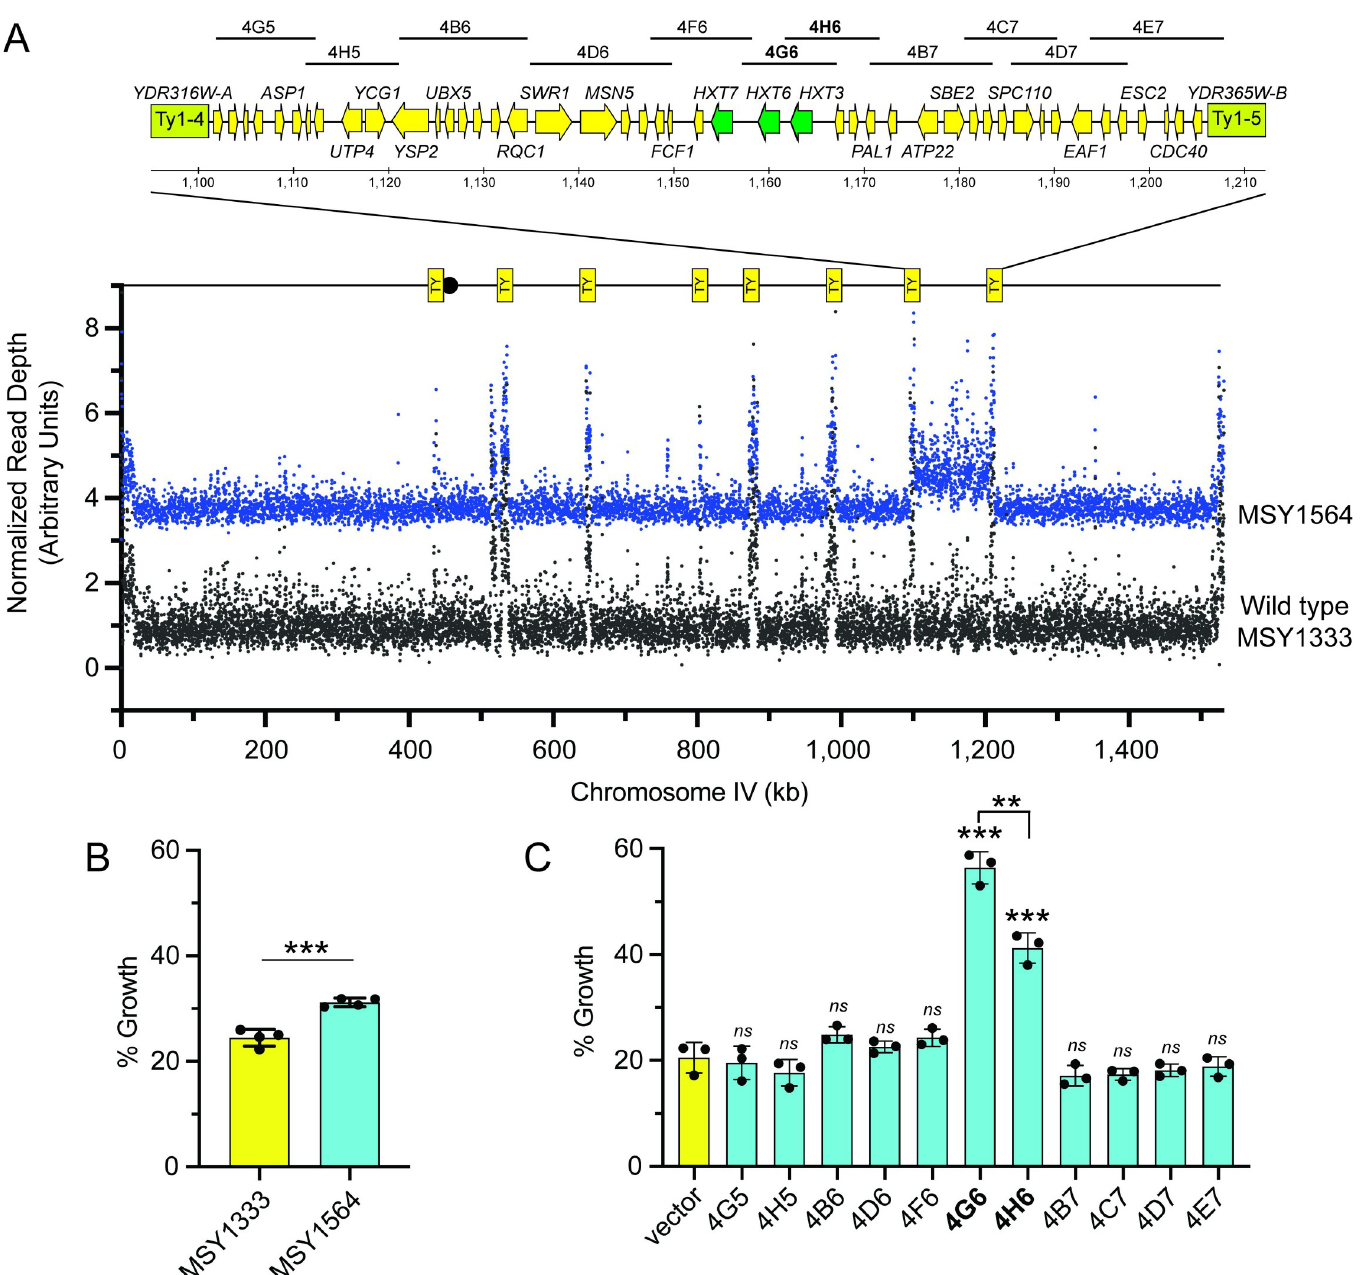
Fig 6. Duplication of HXT367 cluster on chromosome 4 confers 2DG resistance. A. Read depth across chromosome 4 was plotted for the wild type strain (MSY1333) and the haploid strain (MSY1564) bearing the 117 kb duplicated region. Positions of Ty elements flanking the duplicated region and some of the genes within are shown. Regions present in high-copy number plasmid clones [24] covering this region are shown at top. B. 2DG resistance assay performed in quadruplicate showing mean ± SD and statistical significance for haploid strains (1n) with (MSY1564) and without (MSY1333) the 117 kb duplication. C. 2DG resistance in a wild type haploid strain transformed with high-copy number plasmids spanning the duplicated region. Statistical significance for each sample compared to vector is indicated as is a comparison of 4G6 and